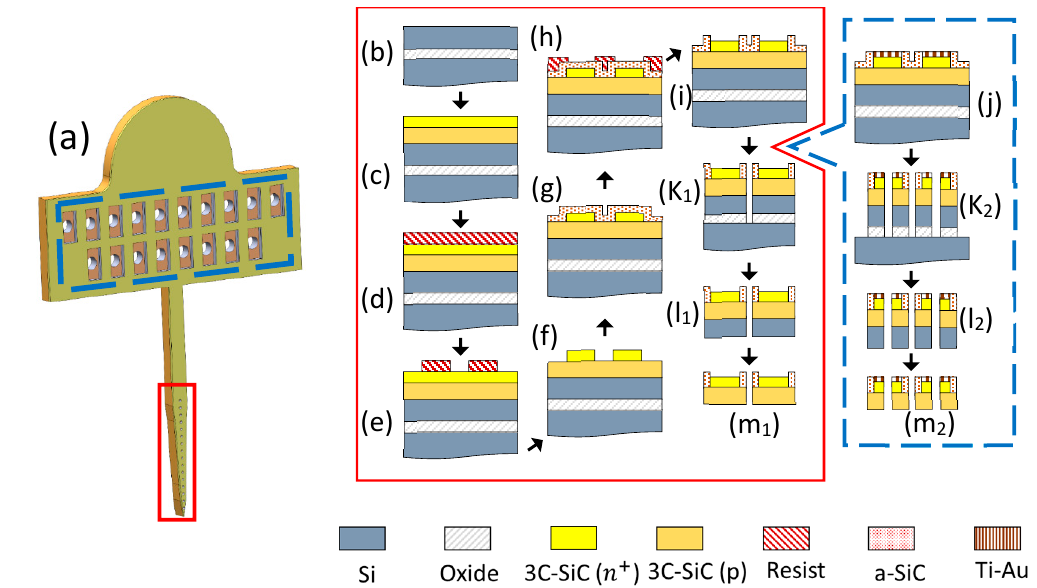
Figure 1. The all-SiC fabrication process flow. ( a ) A rendering of the Michigan-style 3C-SiC probe. The process flow inside the red rectangle shows the cross-section at the electrode sites while the blue rectangle provides the cross-section at the contact pads on the tab. ( b ) Starting SOI wafer, ( c ) ~8 µ m of p-type 3C-SiC was grown on top, followed by ~2 µ m of heavily n-type (n + ) 3C-SiC. ( d ) The wafer was coated with photoresist and ( e ) patterned via photolithography. ( f ) DRIE process was used to form the conductive n + mesas and ( g ) a thin a -SiC insulating layer was deposited on top via PECVD. ( h ) Photoresist was then patterned with photolithography and ( i ) the a -SiC was etched to form windows for the electrode sites using a RIE process. ( j ) After the a -SiC windows were opened, a layer of titanium, followed by gold, was deposited on the contact pads and thermally annealed. A deep DRIE etch through both epi layers and the oxide was performed to (k 1 ) define the probes and (k 2 ) form through-holes in the contact pads. (l 1 , l 2 ) The oxide layer was etched in HF (49%) to release the probes. (m 1 , m 2 ) Back-thinning via DRIE was performed to remove the residual silicon from the SOI device layer.